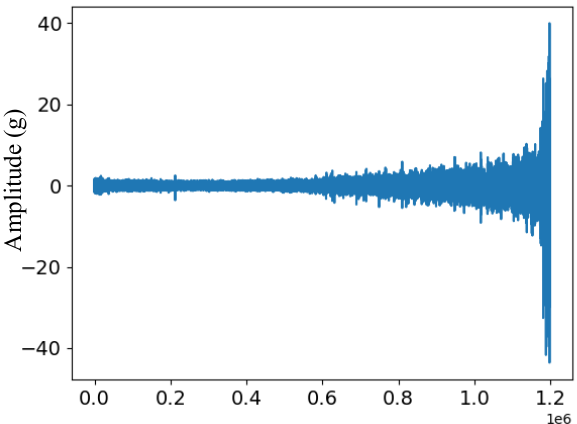
Figure 5. Vibration signal from normal to the degraded condition in an experiment.